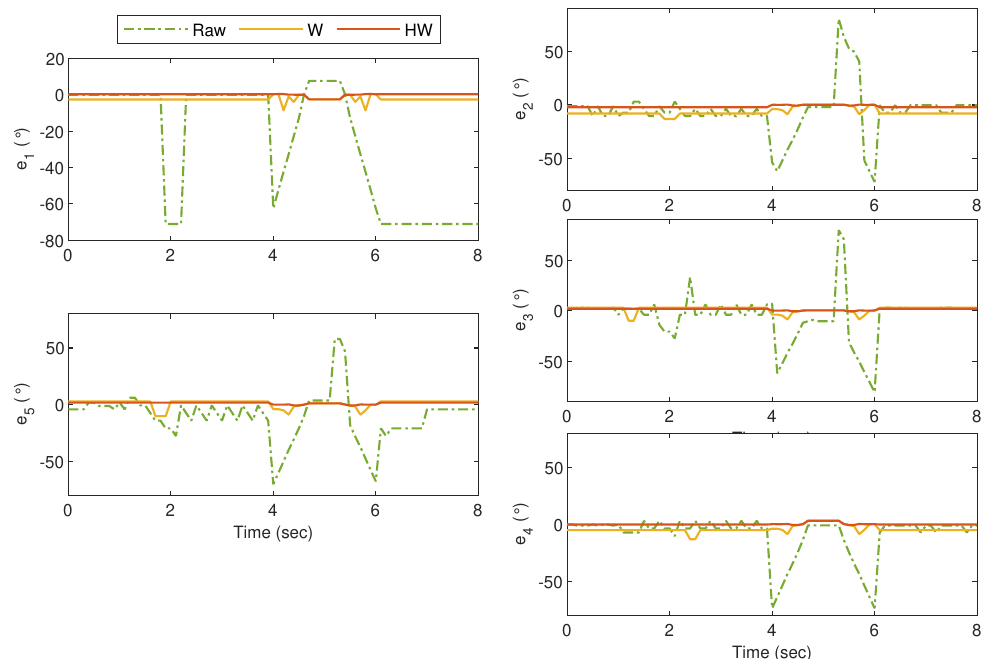
Figure 15. Gesture 1: The corresponding error from the response in Figure 14. The error due to the response from Compensator HW is clearly much lower at all time instances as compared to the